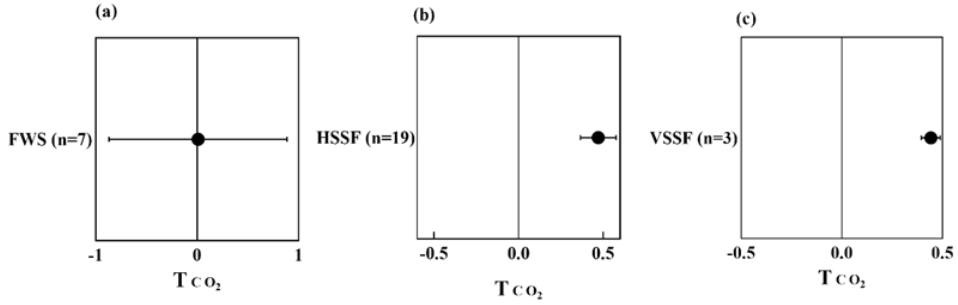
Figure 6. Effect on T index of CO 2 emission from different types of vegetated CWs, i.e., FWS ( a ), HSSF ( b ), and VSSF ( c ), compared to unvegetated CWs.